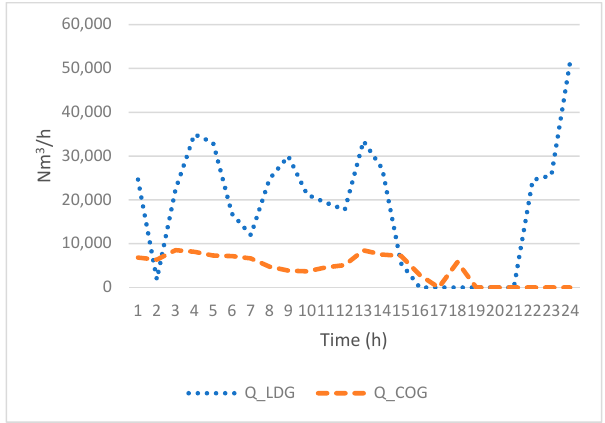
Figure 4. Availability of steel waste gas in the planning period.